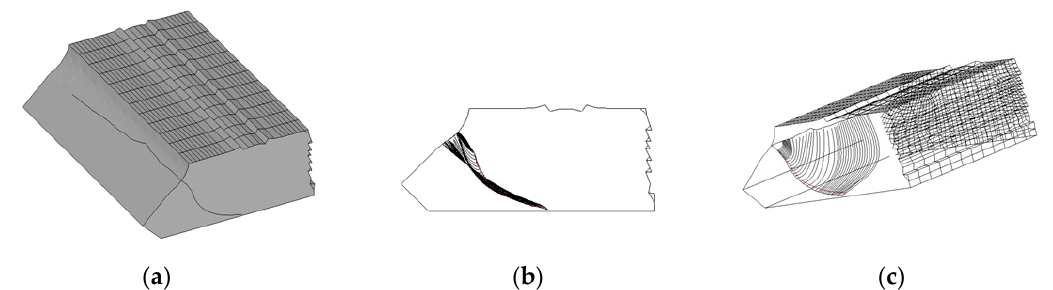
Figure 19. The 45 ◦ angle, short flank crack shape. ( a ) External top view of the crack extension; ( b ) Front view of the crack extension; ( c ) isometric view.